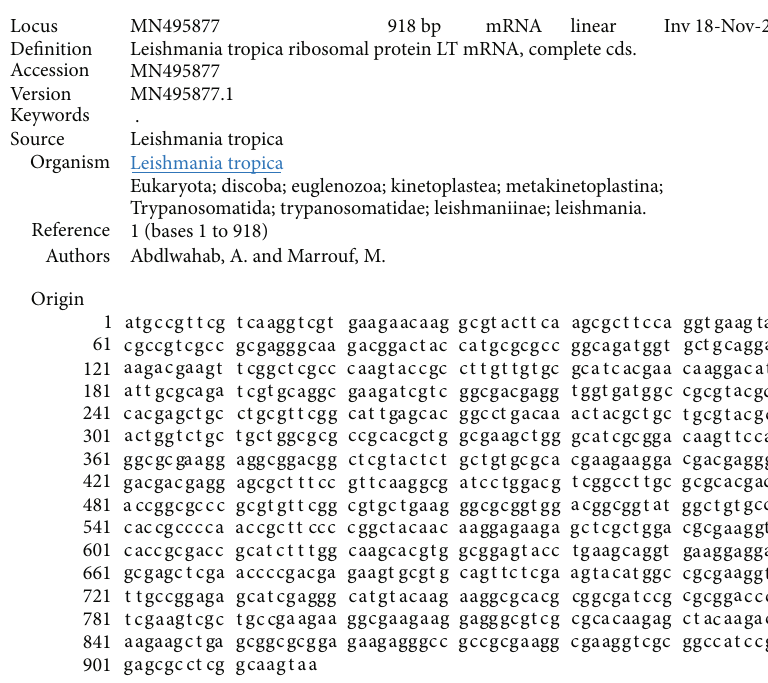
Figure 4: Sequencing of the ribosomal protein L5 gene in the Syrian strain of L. tropica .